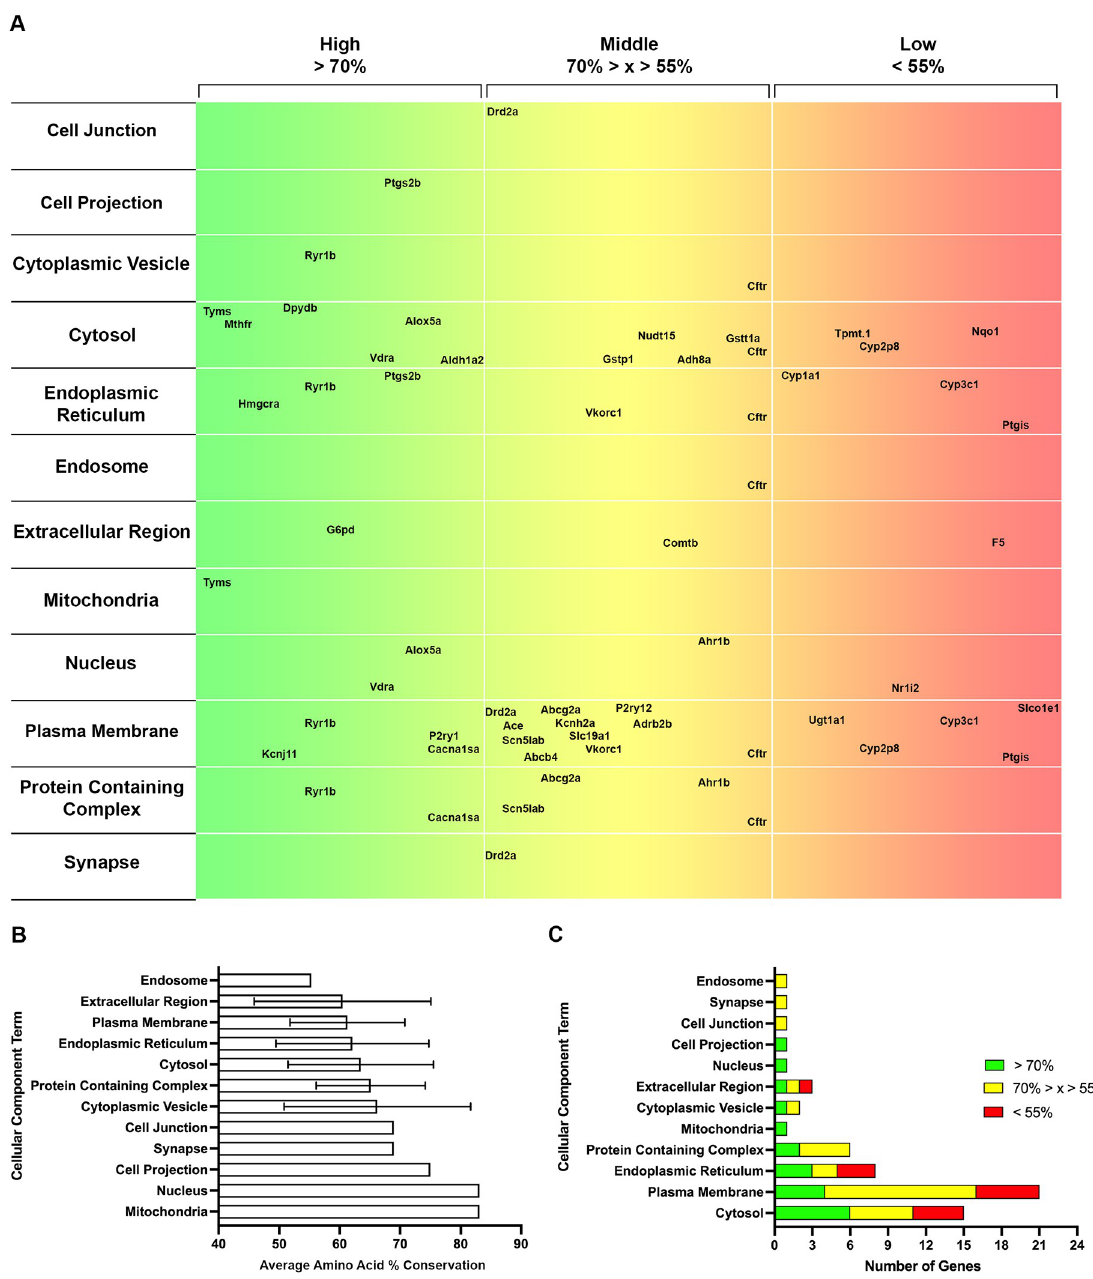
Fig 7. Gene ontology analysis for cellular components of tiered pharmacogenes. A. A map with the Cellular Component terms listed (left), amino acid sequence conservation in 3 groups: > 70% = High (green to yellow, left to right), 70% > x > 55% = Middle (yellow to orange, left to right), and < 55% = Low (orange to red, left to right). The genes are placed within the respective horizontal location based on their % conservation. B. Average amino acid conservation for each Cellular Component term +/- SD. C. The number of pharmacogenes in each category (High = green, Middle = yellow, Low = red) for each Cellular Component term. (n = 1). The best-conserved Biological Process terms, defined by the highest number of genes with > 70% amino acid conservation, were Developmental Process, Carbohydrate Derivative Metabolic Process, and Nucleotide Biosynthetic Process ( Fig 5C ). For Molecular Function, the best-conserved terms were Catalytic Activity, Small Molecule Binding, and Metal Ion Binding